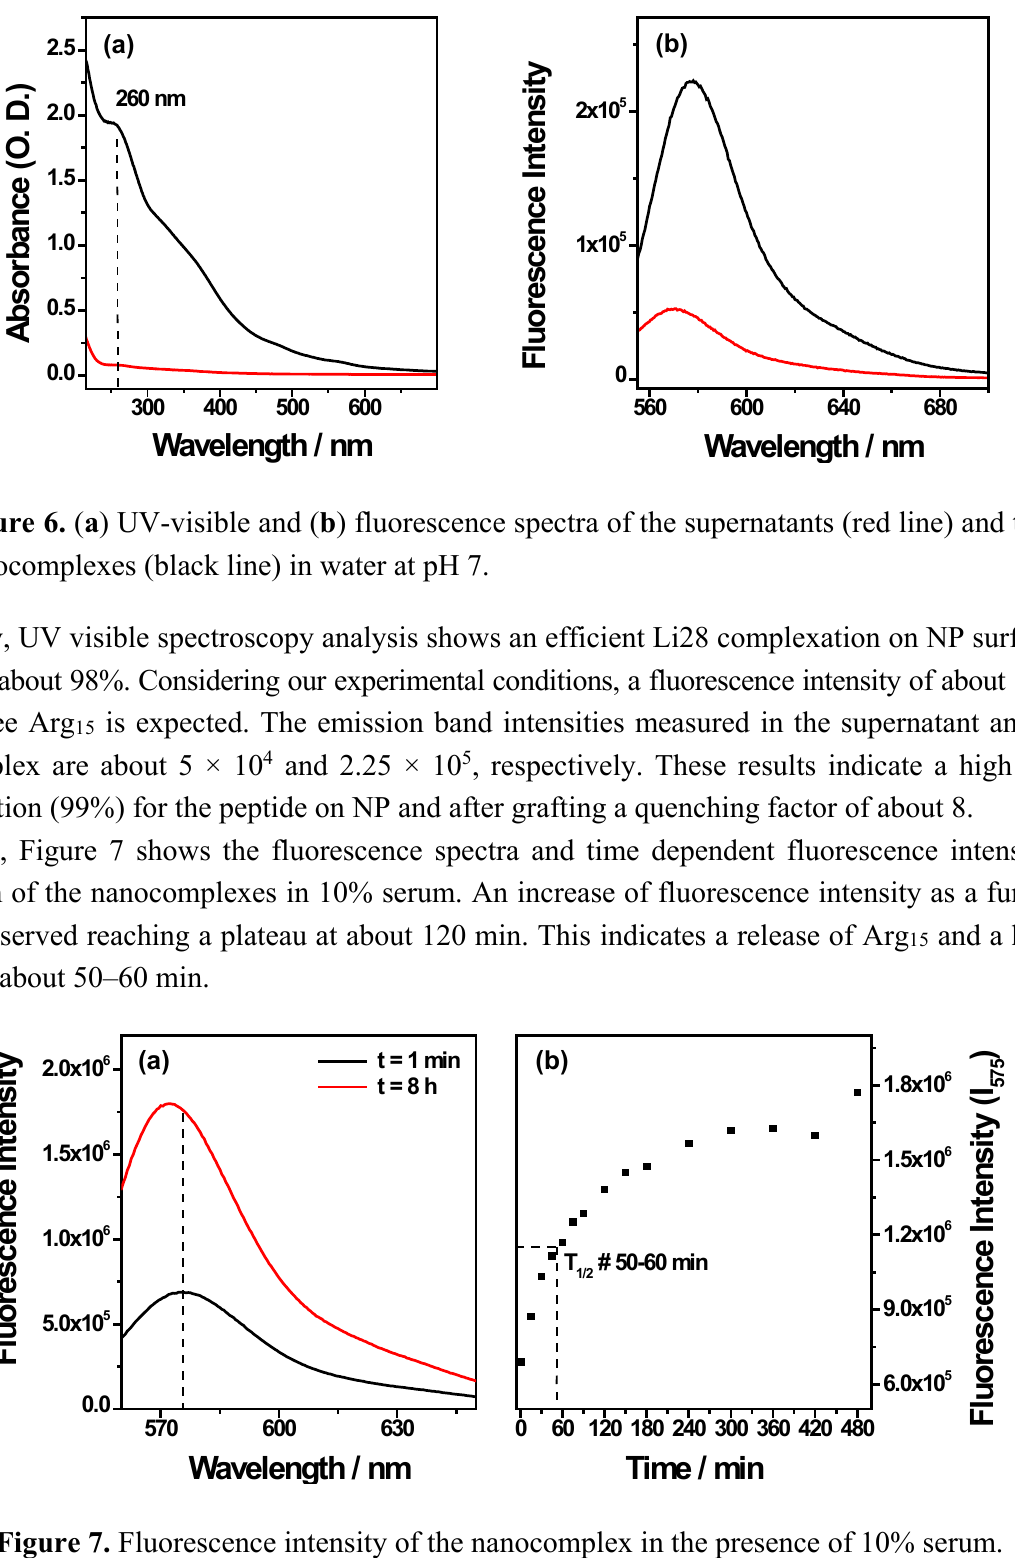
Figure 7. Fluorescence intensity of the nanocomplex in the presence of 10%